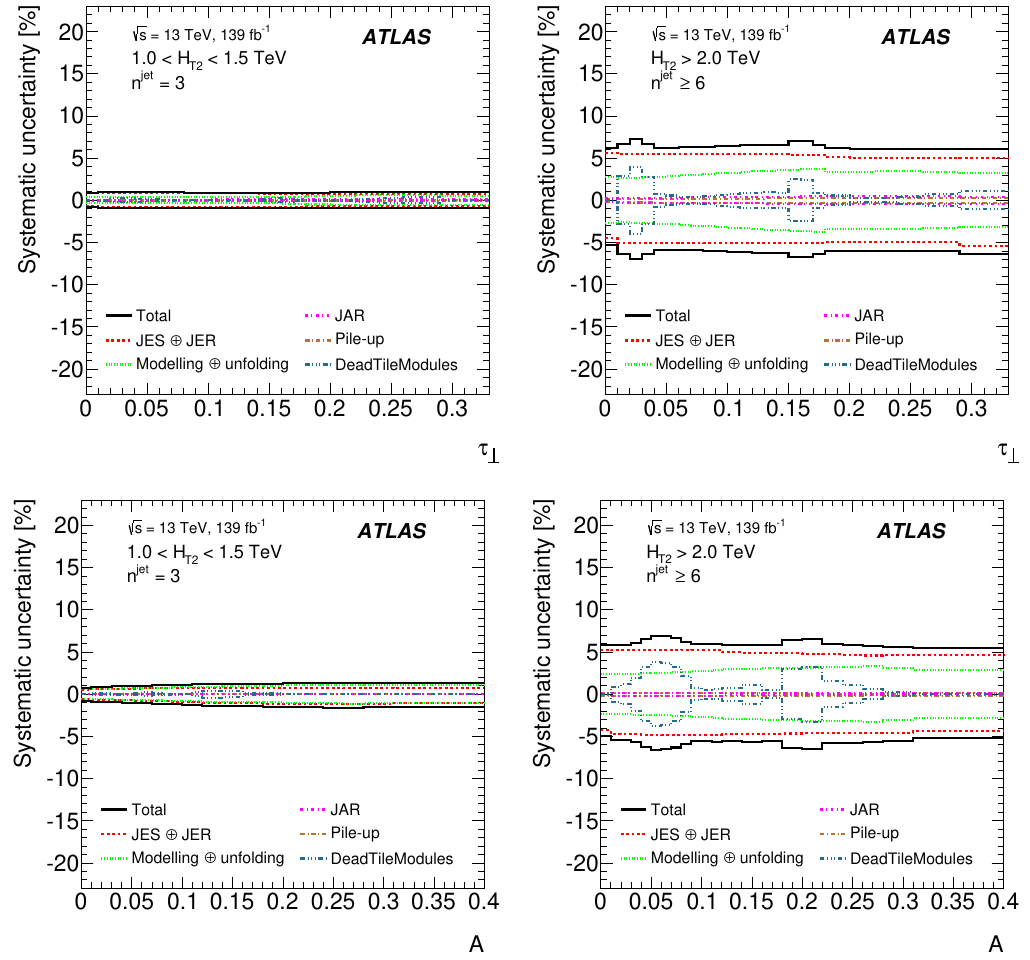
Figure 3 . Breakdown of the systematic uncertainties as a function of τ ⊥ (top) and A (bottom) for selected regions of H T2 and n jet